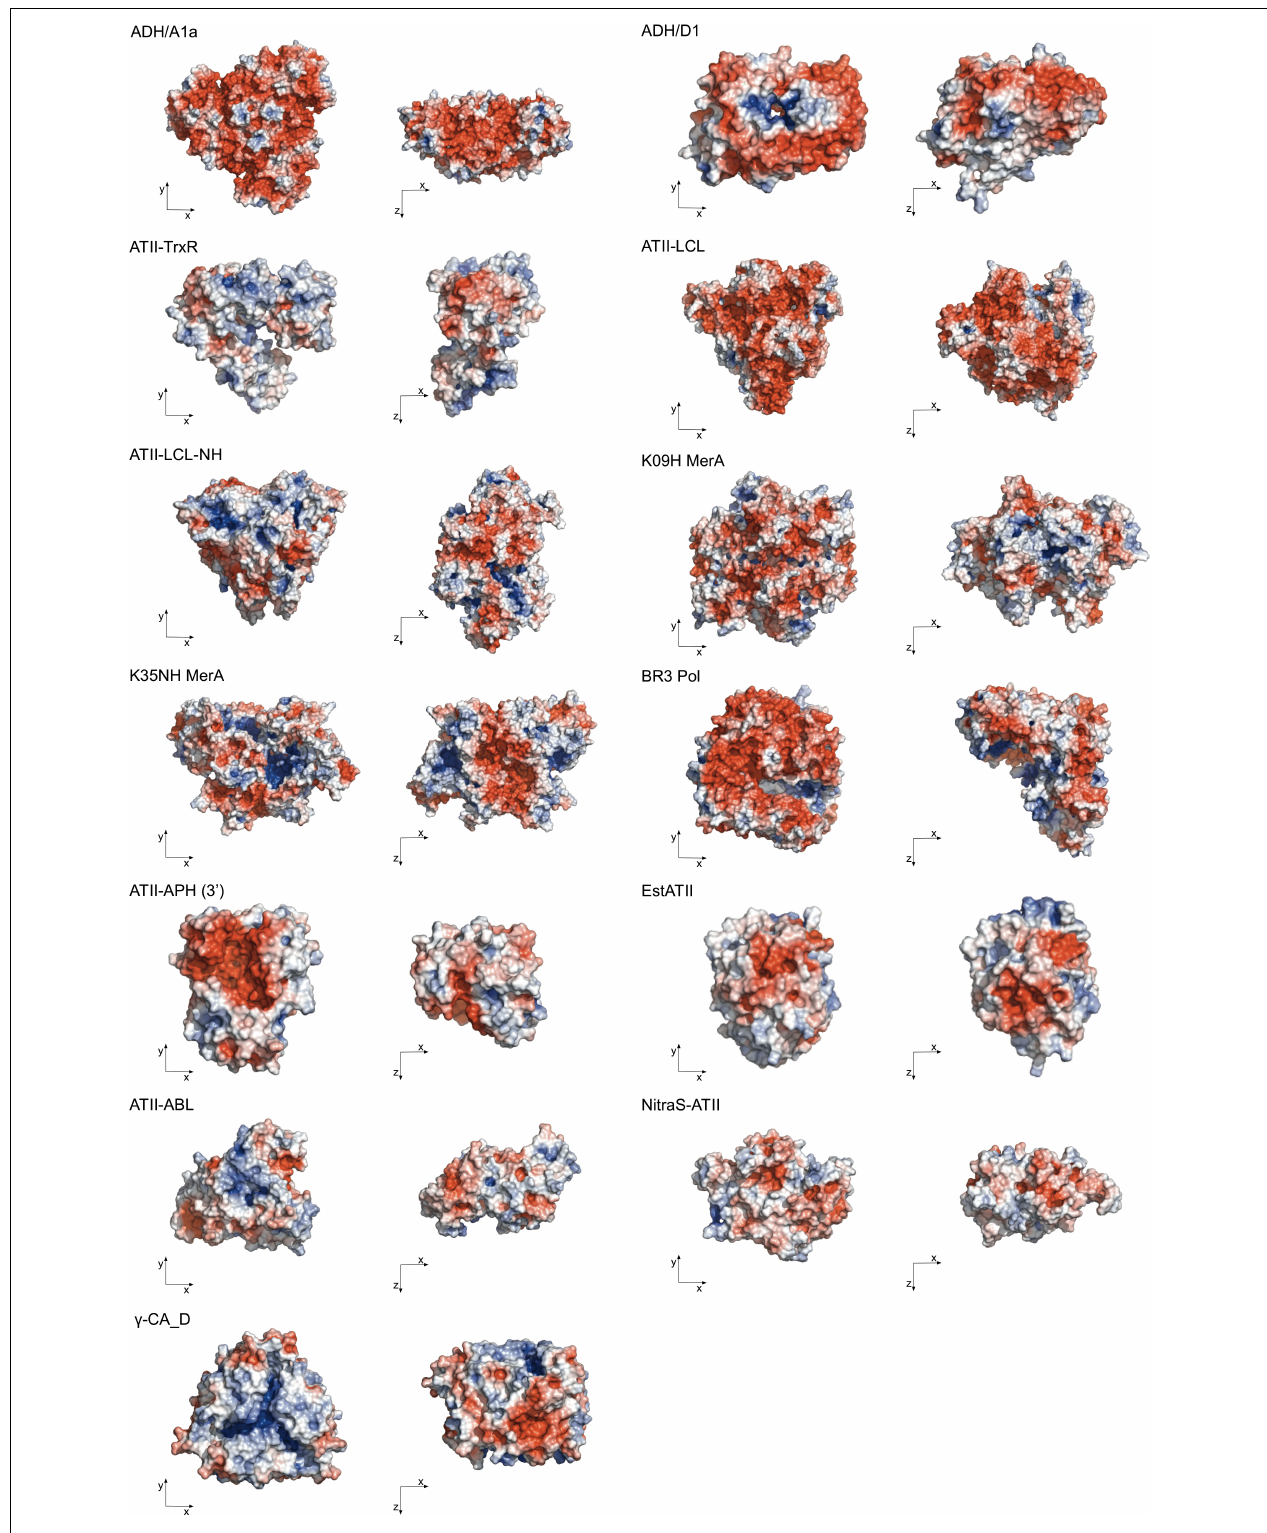
FIGURE 2 | Surface representation of the extremozymes from the Red Sea brine pools. Surface colors indicate positive and negative electrostatic potentials contoured from 50 kT/e (blue) to –50 kT/e (red). The Phyre2 tool (Kelley et al., 2015) was used for homology modeling, with an average 100% confidence level at > 90% accuracy. Visualized by PyMOL Molecular Graphics System, Version 2.4.2, Schrödinger, LLC.